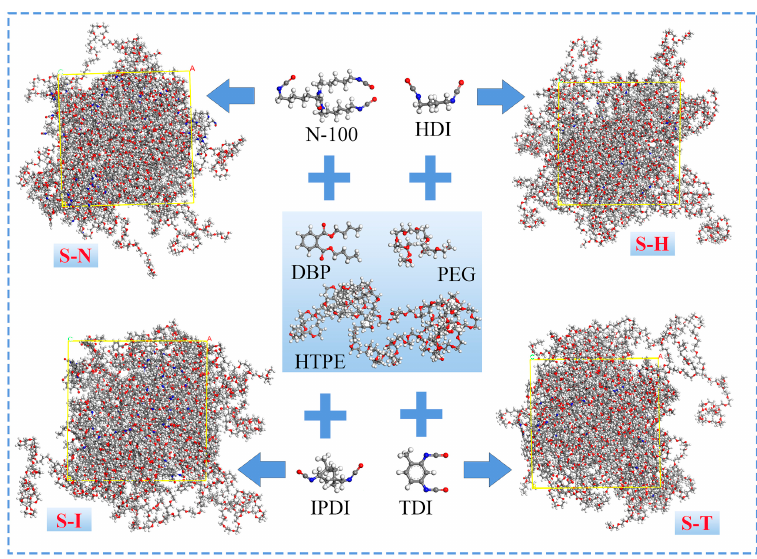
Figure 1. Molecules of prepolymers, curing agents, plasticizers and blended models of four sys- tems.